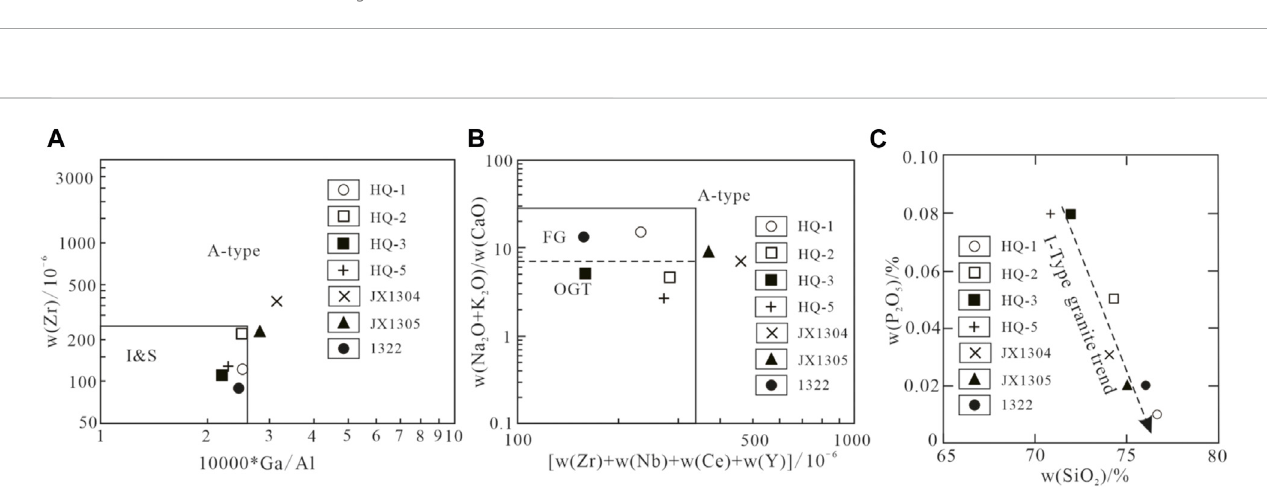
FIGURE 10 Chondrite-normalized REE patterns (A) and Primitive mantle-normalized spider diagrams (B) of granites in the Xinchenggou area, Dongning County (normalized data after Sun and McDonough, 1989).